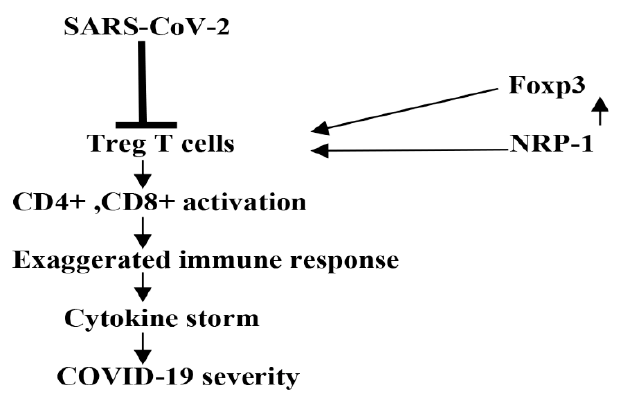
Figure 7. The role of neuropilin-1 (NRP-1) in SARS-CoV-2 infection-induced abnormal immune response: SARS-CoV-2 infection inhibits regulatory T cells (Treg), causing abnormal activation of CD4+ and CD8+, and the development of a cytokine storm.